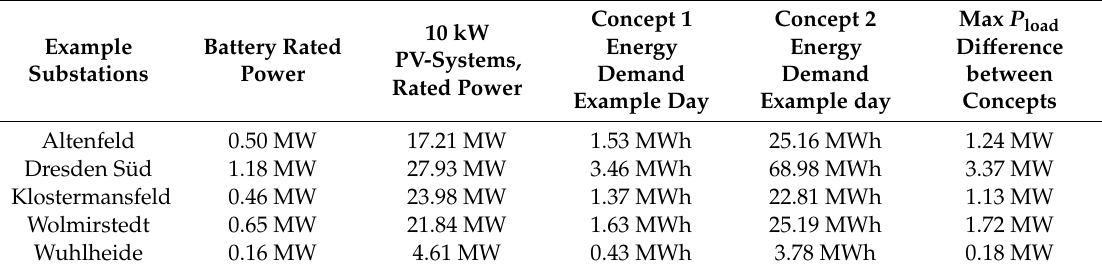
Table 7. Substation-specific data for example